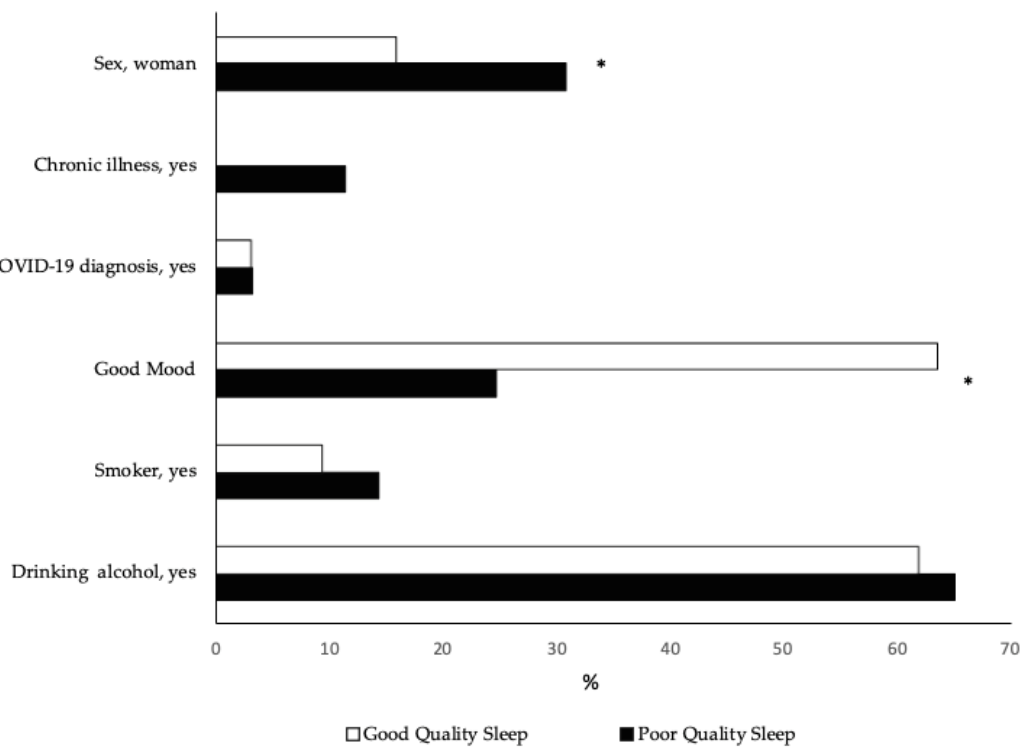
Figure 2. Sleep quality according to sociodemographic and health characteristics. * p < 0.05.